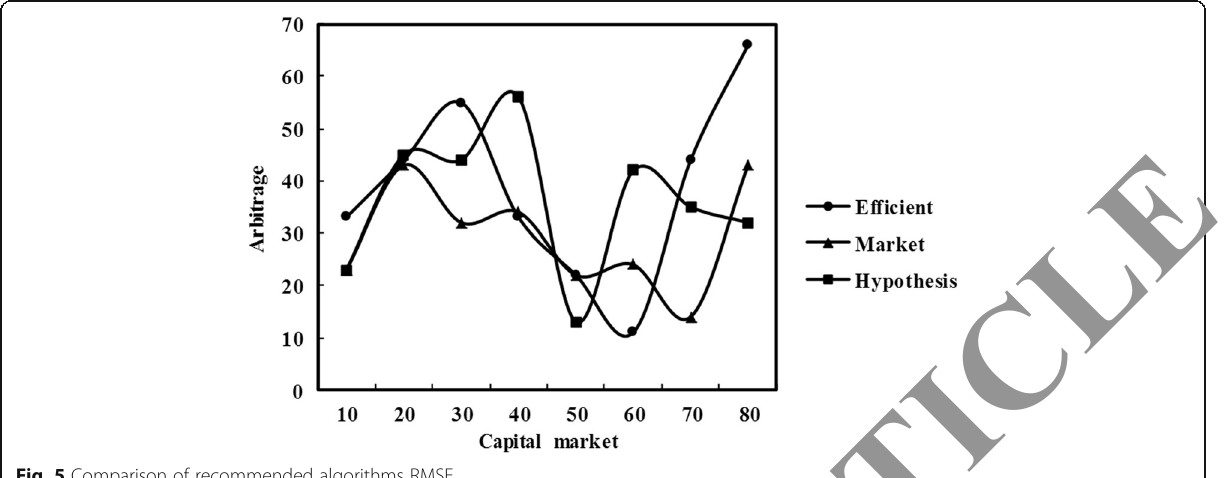
Fig. 5 Comparison of recommended algorithms RMSE